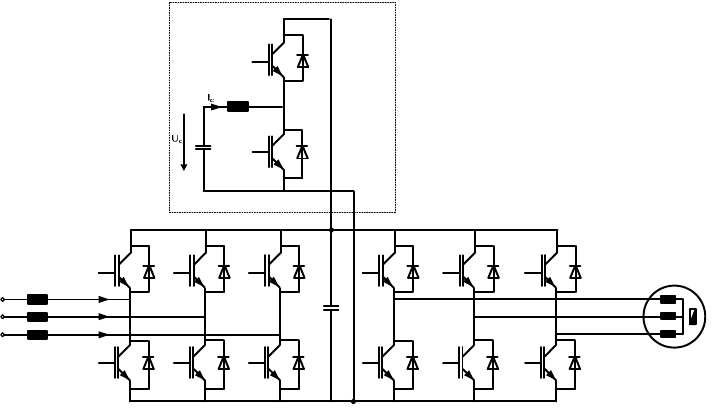
Figure 19. Detailed scheme of the power electronic converter with active power compensation.